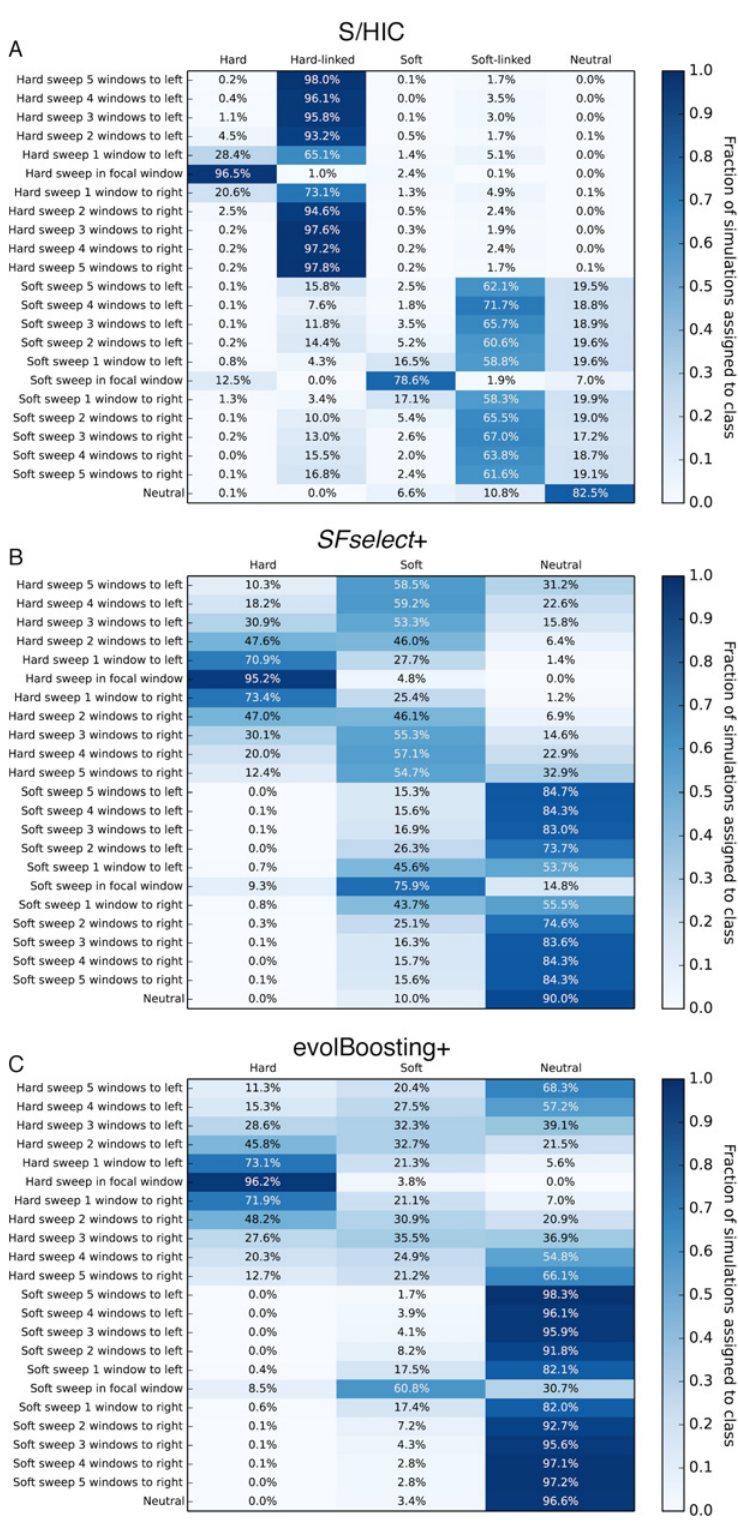
Fig 4. Heatmaps showing the fraction of regions at varying distances from sweeps inferred to belong to each class by S/HIC, SFselect +, and evolBoosting+. The location of any sweep relative to the classified window (or "Neutral" if there is no sweep) is shown on the y -axis, while the inferred class on the x -axis. Here, α ~ U (2.5×10 2 , 2.5×10 3 ). A) Results for S/HIC. B) SFselect +. C)